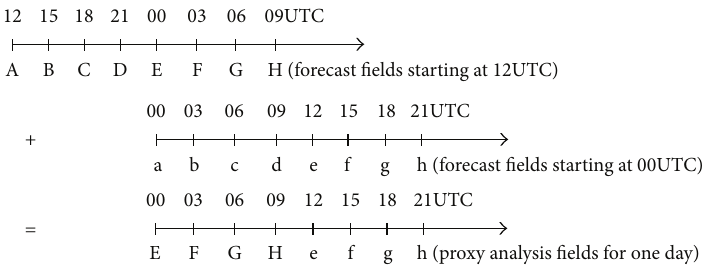
Figure 1: Construction of proxy analysis fields of PBLH for one day using short-term model forecast fields. The 00–09h forecasts are not used to avoid the model spin-up effect.